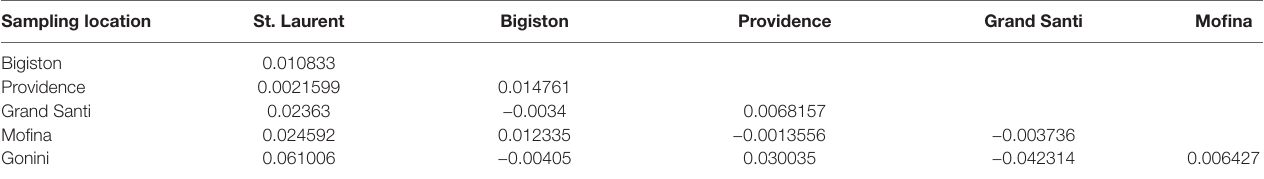
TABLE 1 | Genetic differentiation between sampling locations. Fixation index was computed as Weir and Cockerham’s weighted Fst (Weir & Cockerham, 1984). Sampling